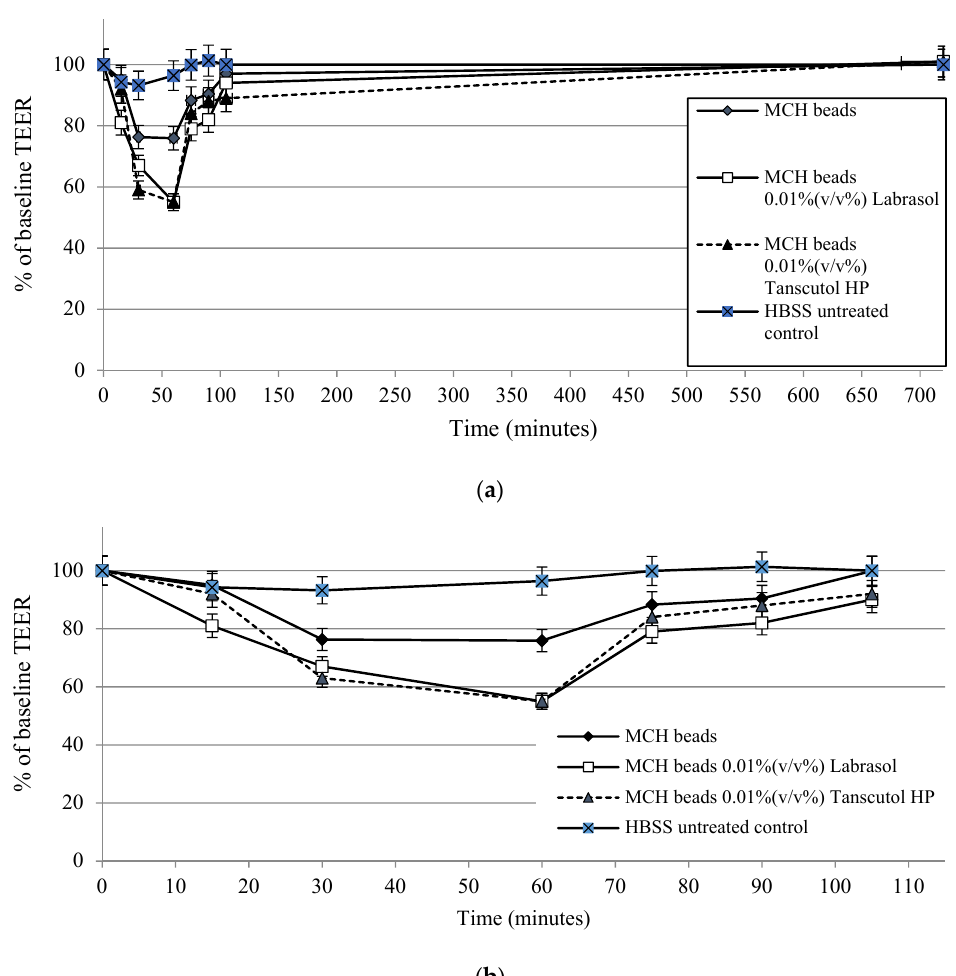
Figure 10. Transepithelial electrical resistance of Caco-2 intestinal epithelial cells: ( a ) regarding the whole experiment; ( b ) focusing on the first 100 min. Each data point represents the mean ± SD, n = 5.